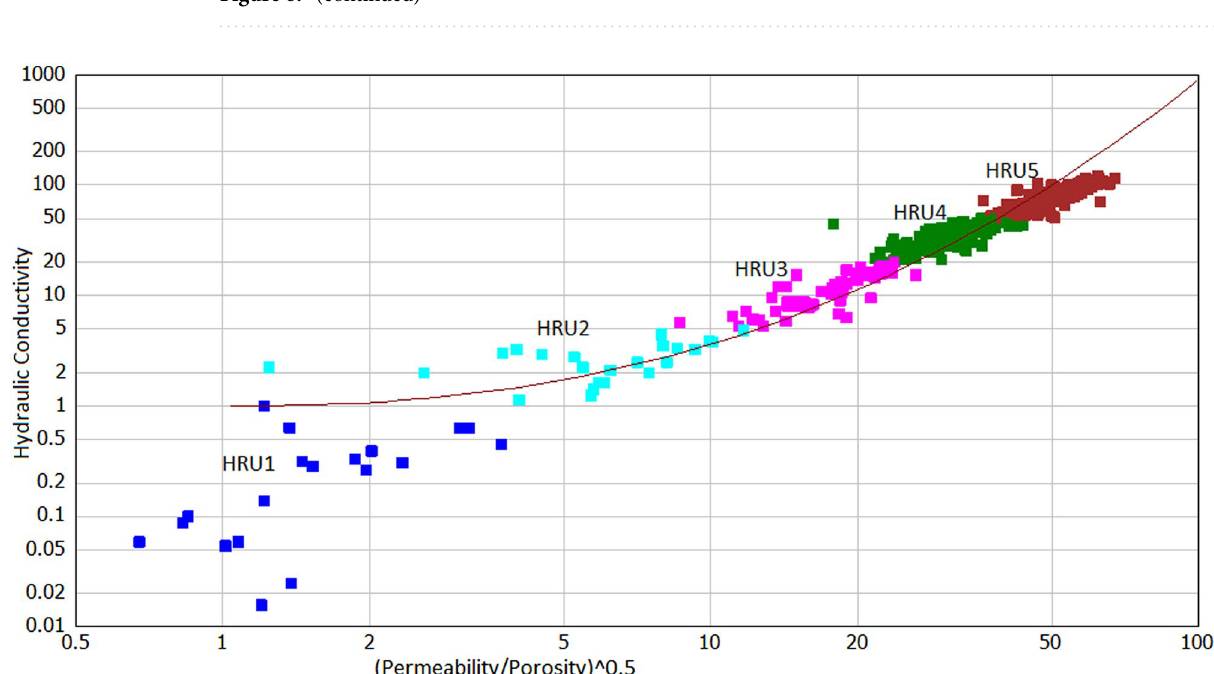
Figure 7. Cross plot of hydraulic conductivity against K/Phi indicating hydraulic reservoir units encountered in the